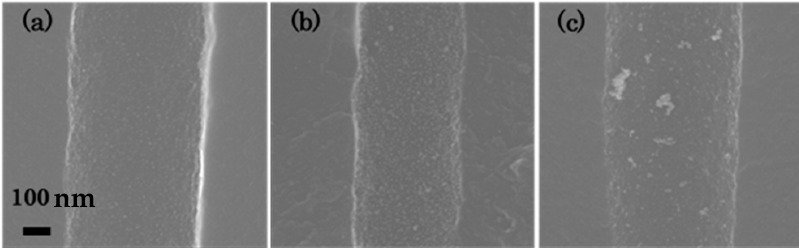
Figure 3. Cross-sectional SEM images of capillaries created under di ff erent H 2 PtCl 6 concentrations: ( a ) 0.1 mmol / L, ( b ) 0.5 mmol / L, and ( c ) 10 mmol / L.